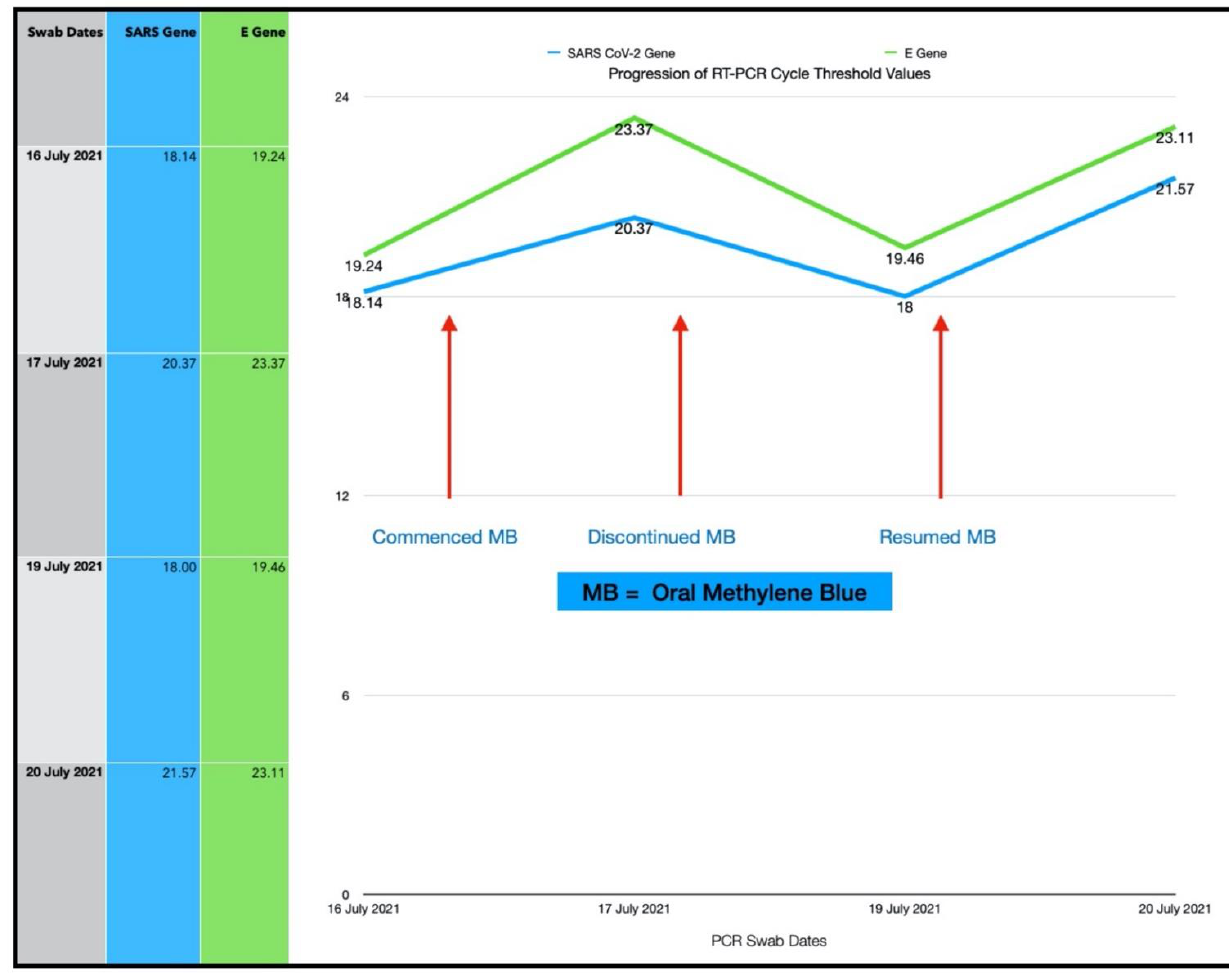
Figure 11. Shows the serial CT progression of subject five.